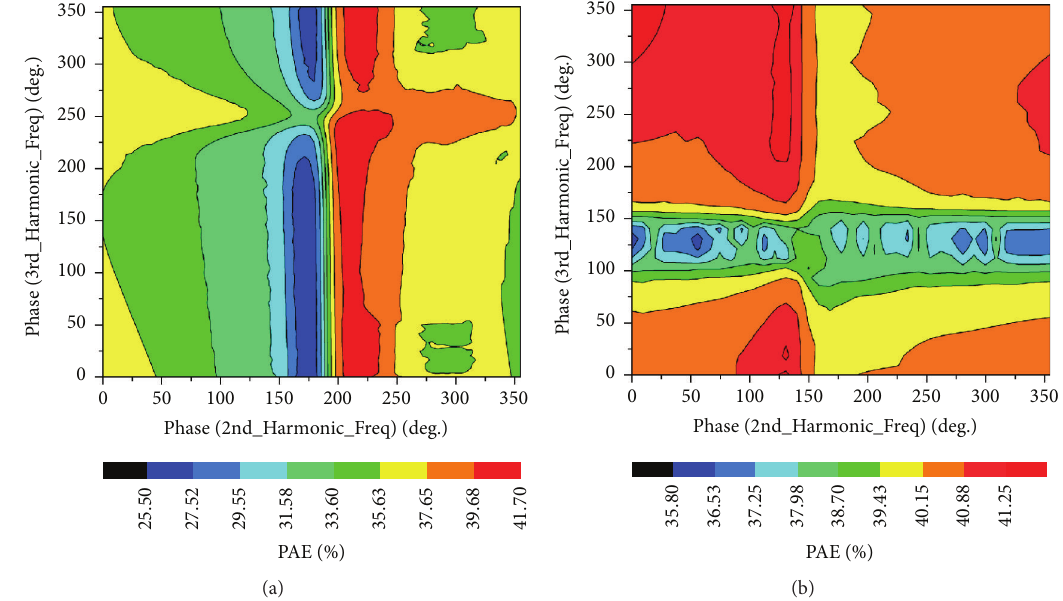
Figure 2: The source (a) and load (b) pull PAE contour of harmonics for the 4 × 65 𝜇 m pHEMT.